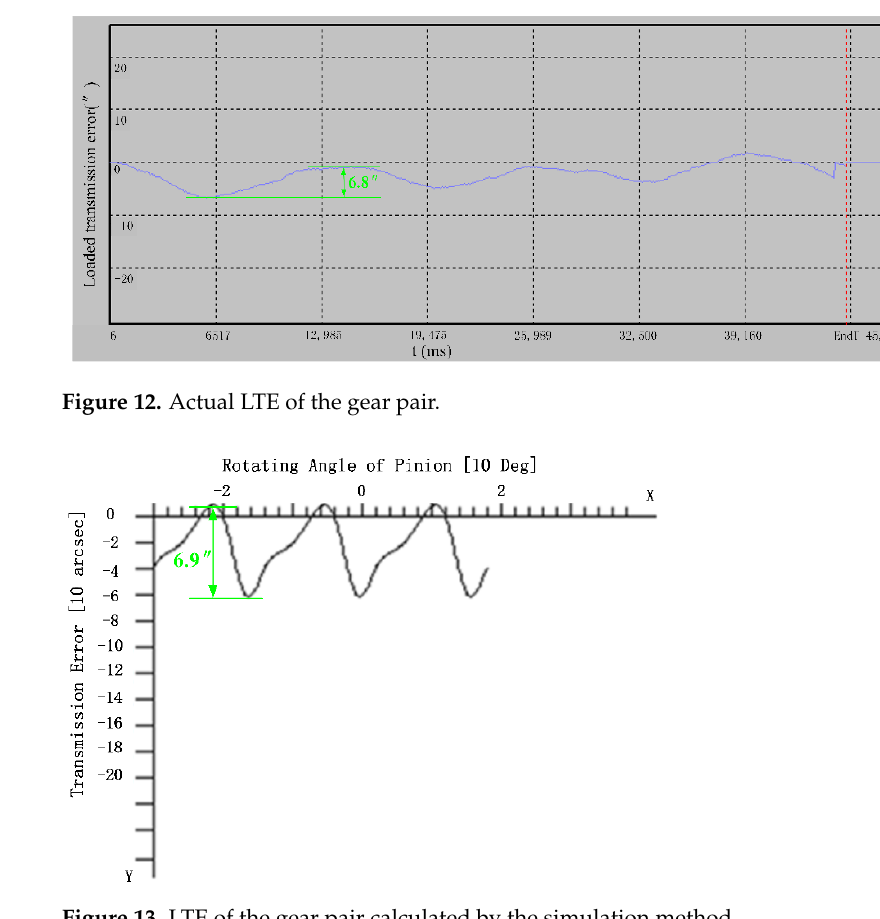
Figure 11. Actual rotation angles of the pinion and the gear.